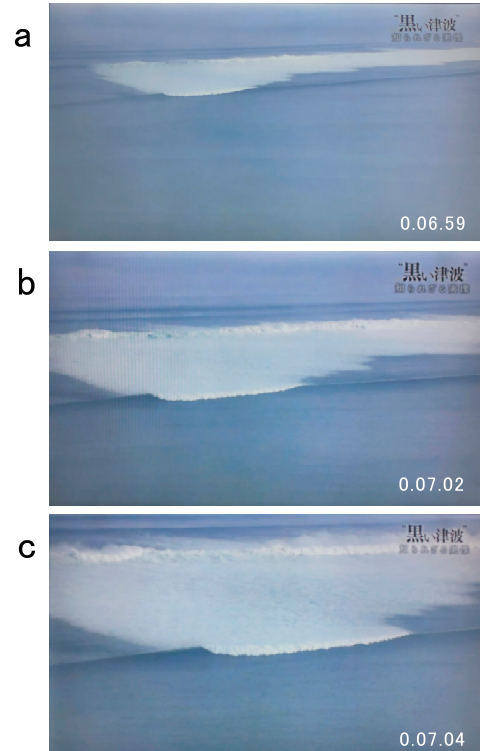
Figure 4. ( a – c ) Generation and propagation of whitish-bubbled tsunami water at 16:12 (local time) on 11 March as photographed in the 2011 Tohoku-Oki earthquake offshore of Sendai Bay, Natori city (see Figure 1a). Note that tsunami waters covered by smoke/mists are pushing numerous bubbles as they rush toward the shore. NHK TV video imagery from “Kuroi tsunami shirarezaru jituzo (in Japanese)” (Black tsunami, unknown images), which aired on March 3, 2019.